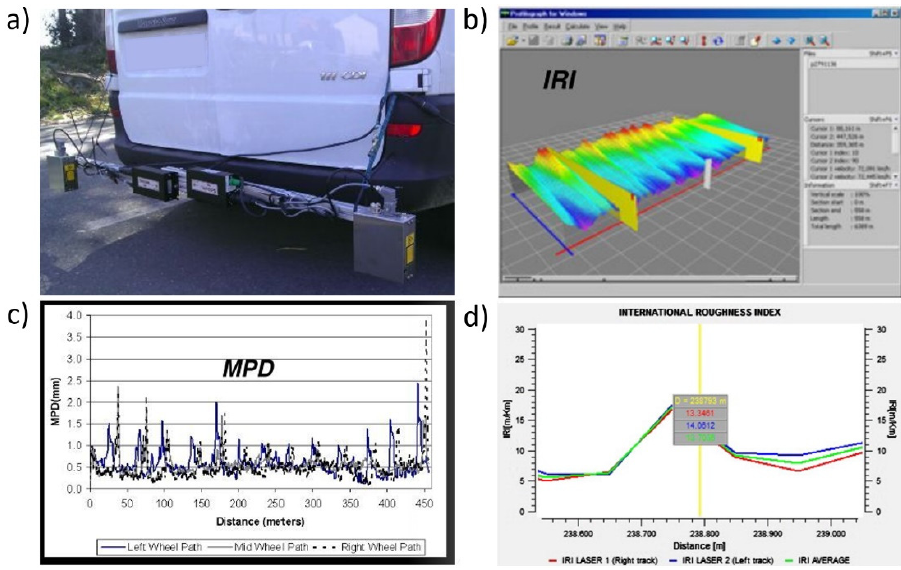
Figure 5. The IRI. ( a ) Two profilometers mounted on a vehicle and ( b – d ) examples of roughness, MPD and IRI measurements, respectively.